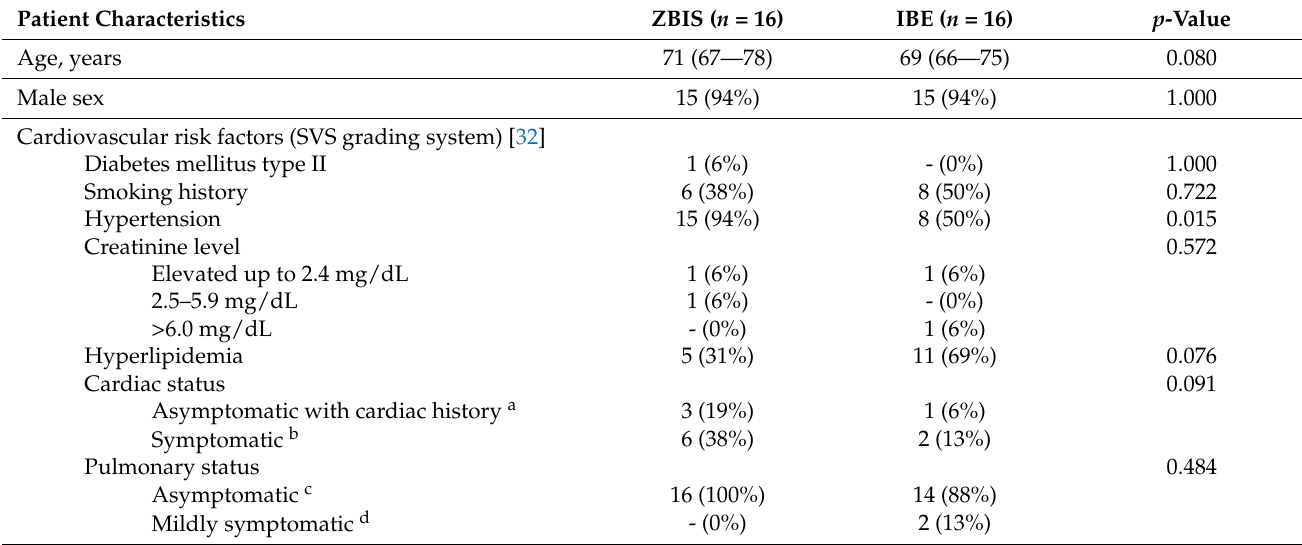
Table 1. Patient, anatomical and procedural